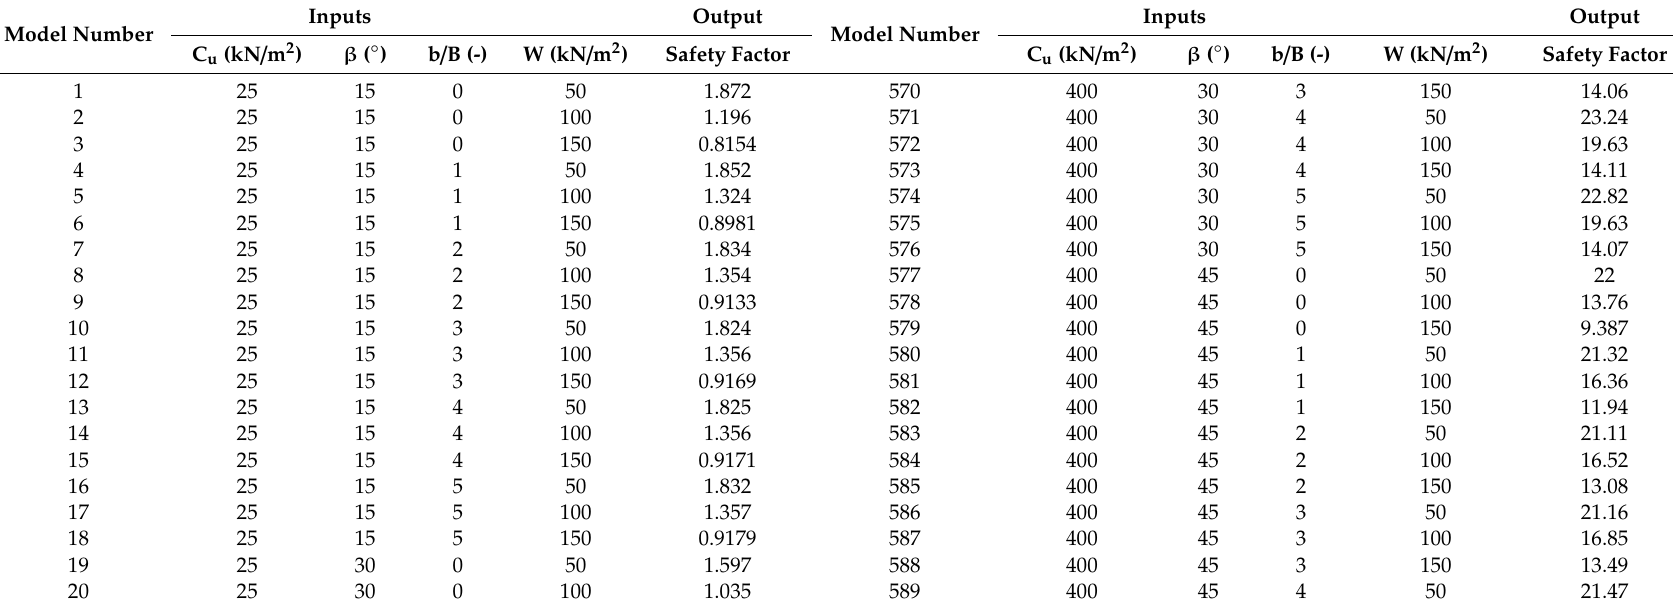
Table 1. Databases includes input layers and output used for the trained